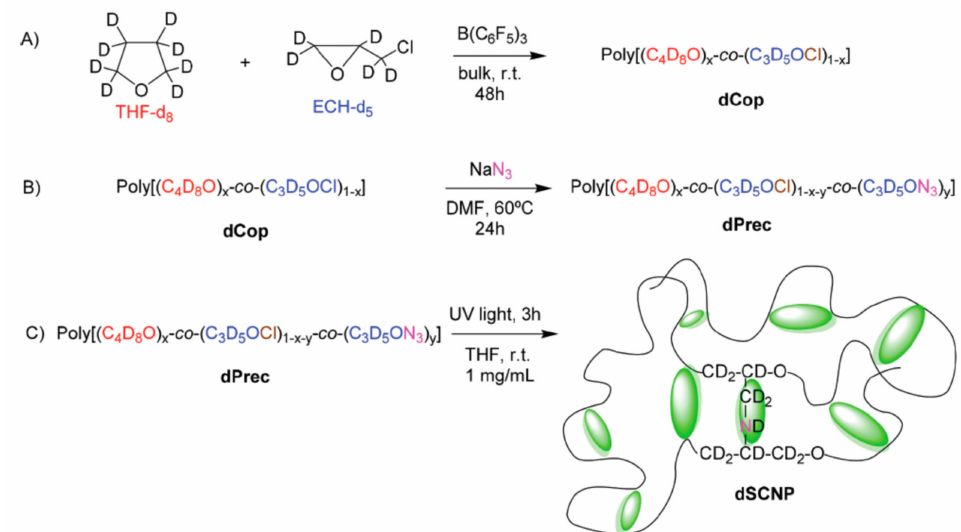
Figure 10. Schematic illustration of the di ff erent steps during the synthesis of completely deuterated SCNPs: ( A ) Bulk ring-opening copolymerization of available perdeuterated cyclic ether monomers. ( B ) Post-polymerization functionalization reaction with sodium azide. ( C ) SCNP formation via photogeneration of nitrene species followed by intrachain nitrene C–H insertion events. Reprinted from [41] with